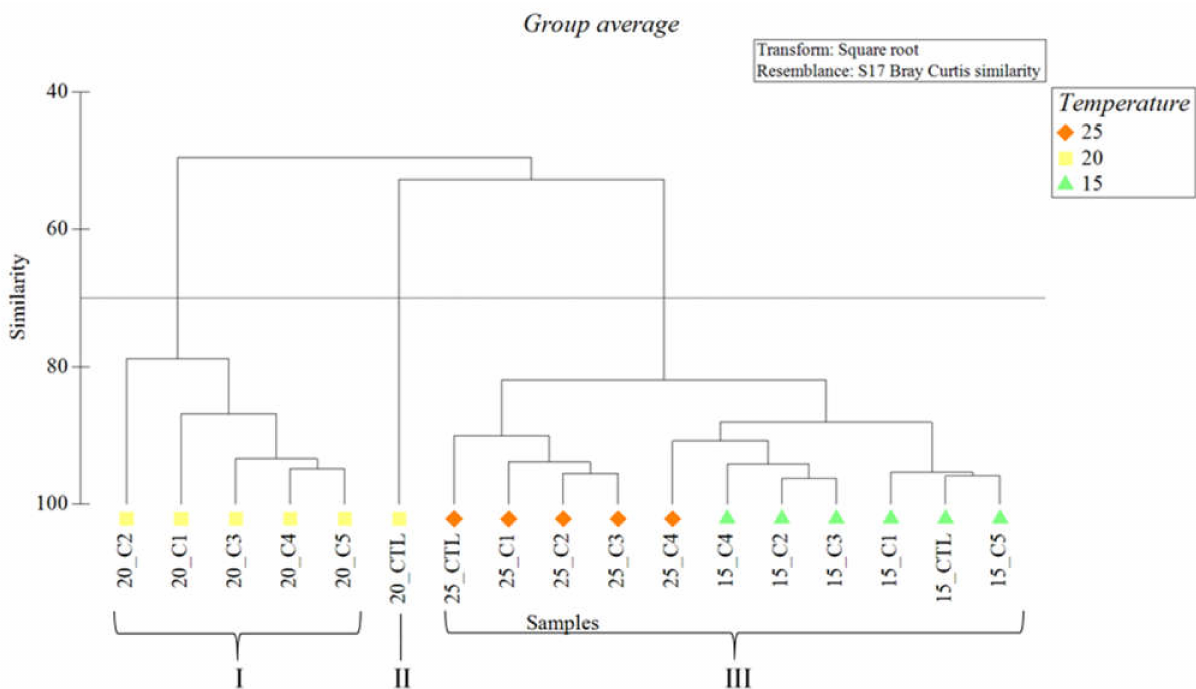
Figure 10. Cladogram (cluster analysis) grouping the diatoms, related with the neutral sugar content after exposure to copper sulfate at 15 ◦ C, 20 ◦ C, and 25 ◦ C.